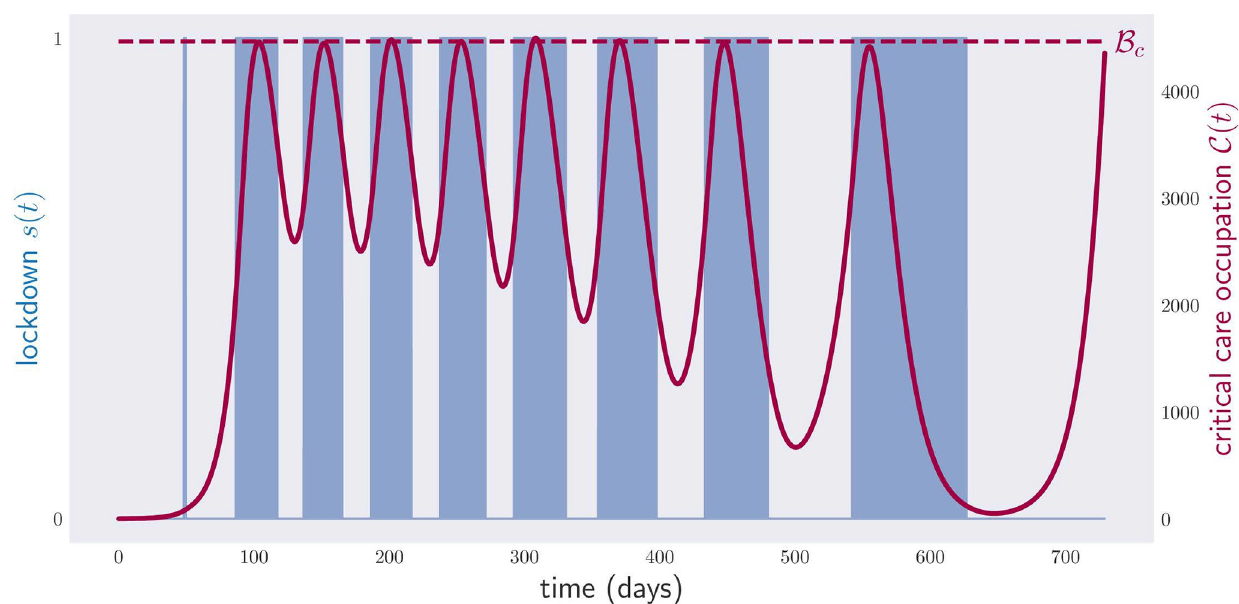
Fig 6. Occupation of critical care beds (red) and lockdown measures (blue) for a period of two years. Optimization over deterministic policies with arbitrary initial and final times for each lockdown period. A total of 9 lockdown periods has been fixed prior to the optimization. Notice that the first lockdown period, around day 60, has been basically removed by the optimization